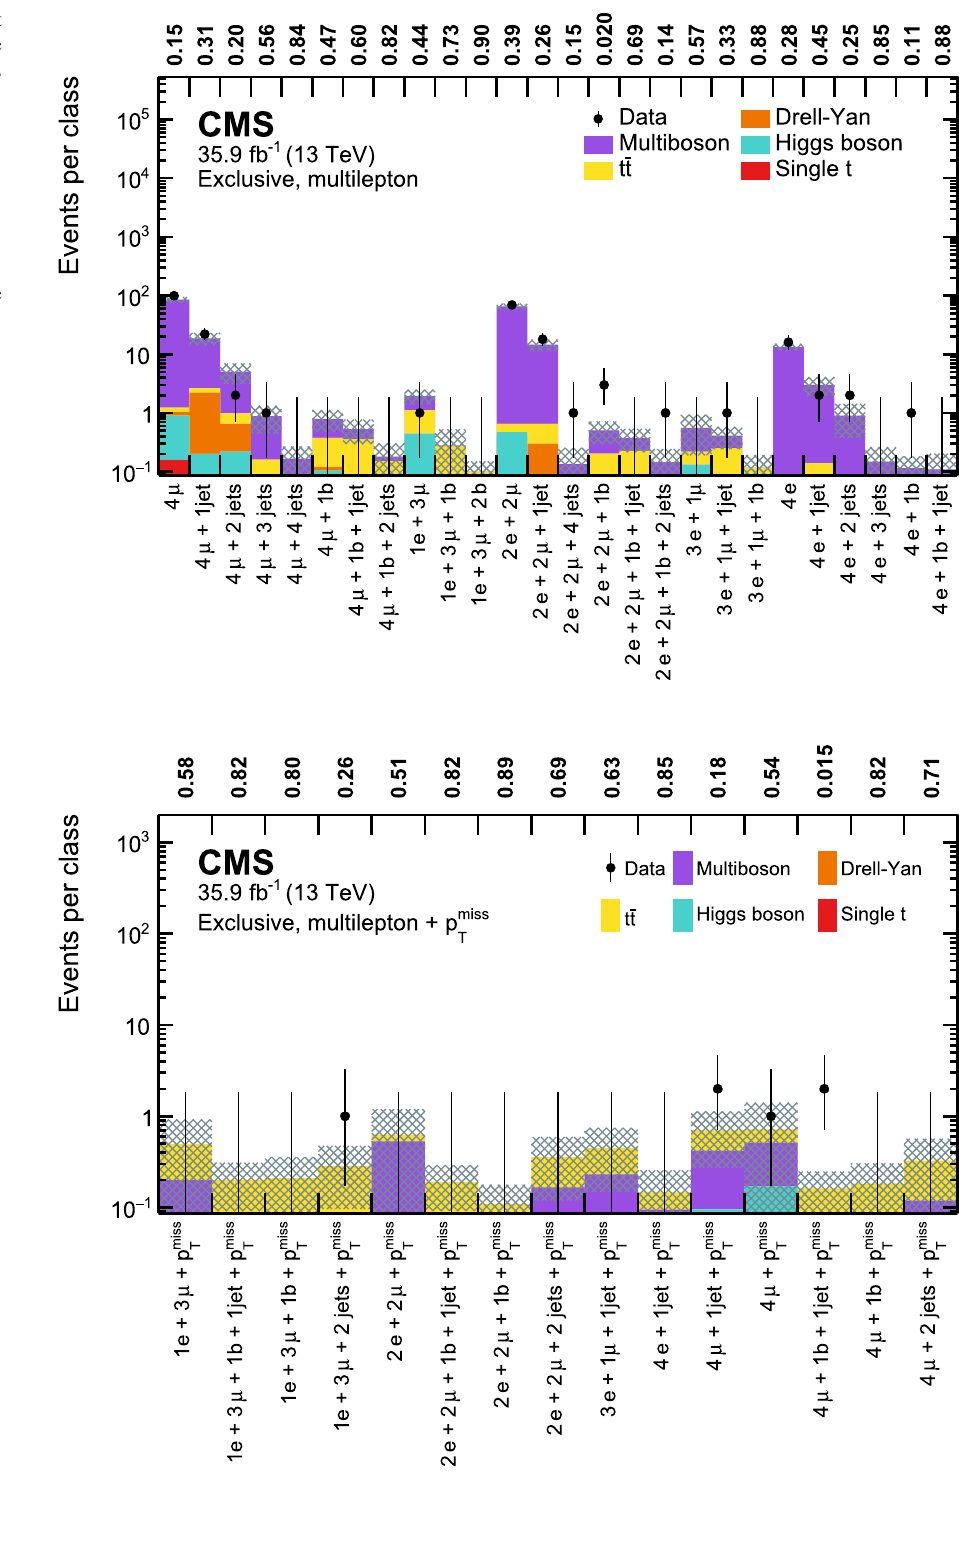
Fig. 22 Overview of total event yields for the event classes of the ≥ 4 leptons object group (upper), and the ≥ 4 leptons + p miss T object group (lower). Measured data are shown as black markers, contributions from SM processes are represented by coloured histograms, and the shaded region represents the uncertainty in the SM background. The numbers above the plot indicate the observed p value for the agreement of data and